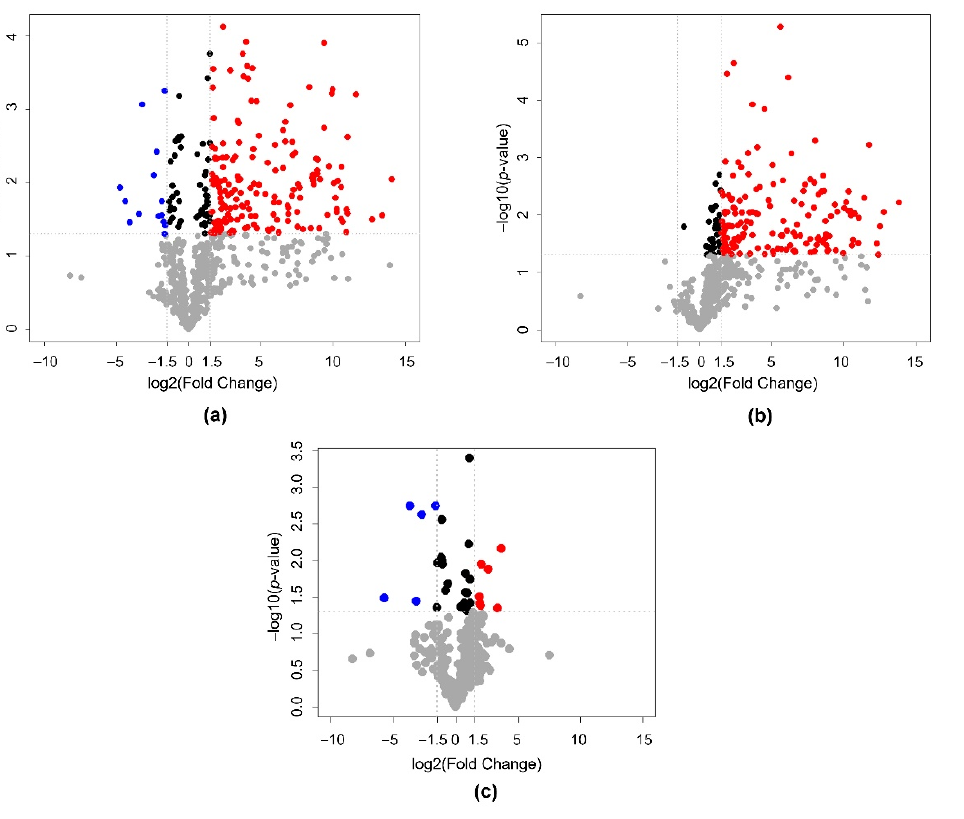
Figure 1. Volcano plots illustrate the significant differences in DAMs between three pairwise compar- ison sets of the cultures using different carbon sources ( a ) C5 vs. C6 cultures, ( b ) C12 vs. C6 cultures, and ( c ) C5 vs. C12 cultures. Red and blue dots represent the significantly up- and down-accumulated metabolites under |log 2 fold change| ≥ 0.5 and p -value ≤ 0.05, respectively. Gray and black dots indicate DAMs with no significant